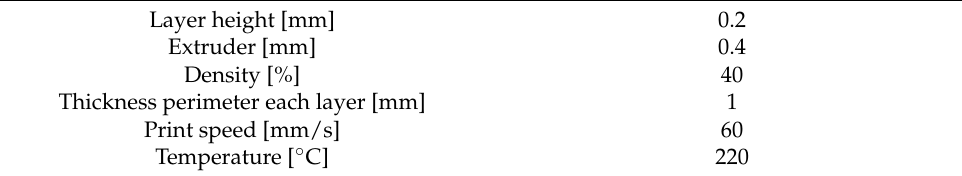
Table 4. Different parameters used for the manufacturing of the leg